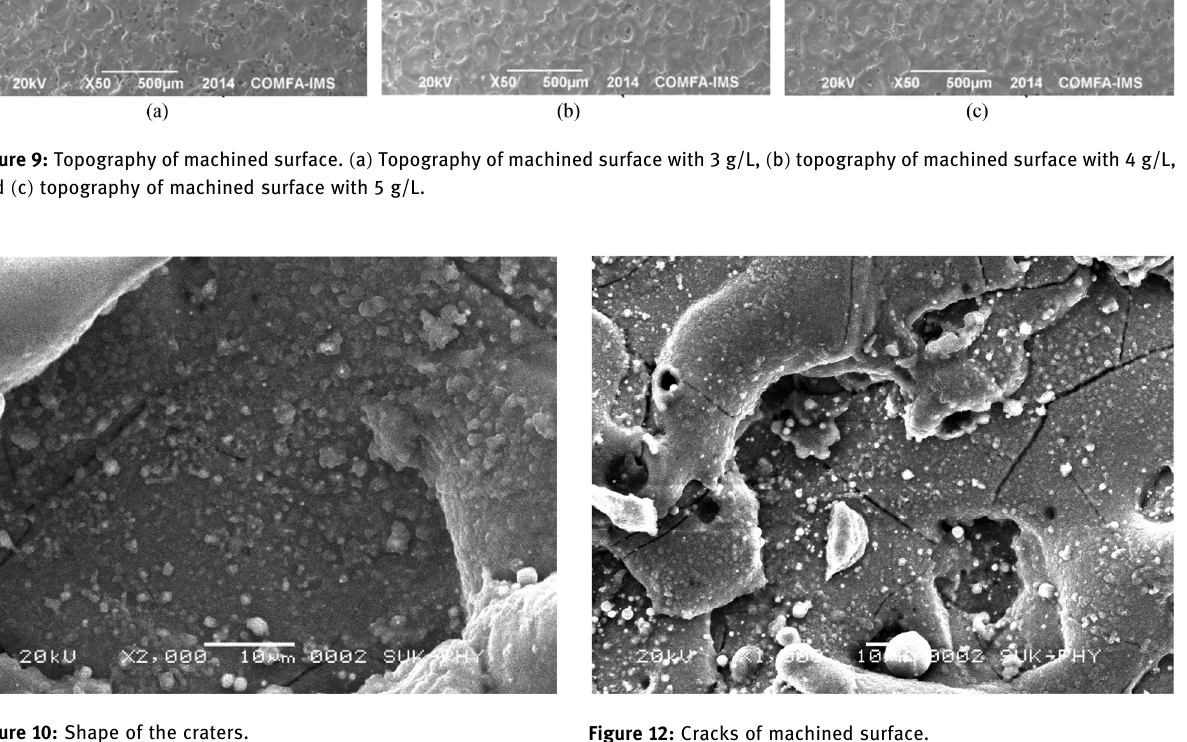
Figure 12: Cracks of machined